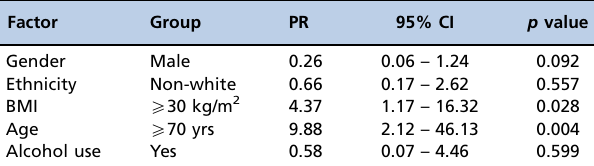
Table 4 - Prevalence Rates of Qualitative and Categorized Quantitative Variables – Natural